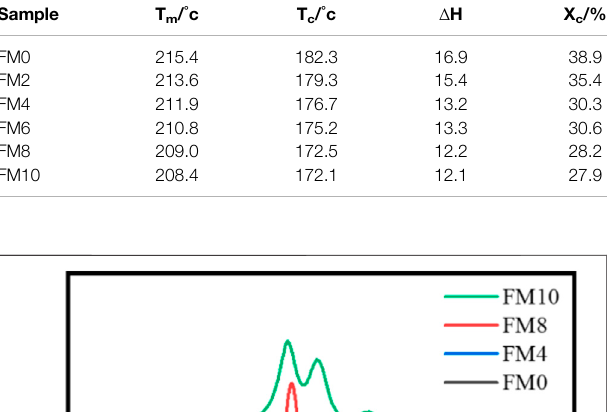
TABLE 3| T m ,T c , Δ H,andX c ofneatPCTFEandPCTFE/FCOmeasured byDMA. Sample